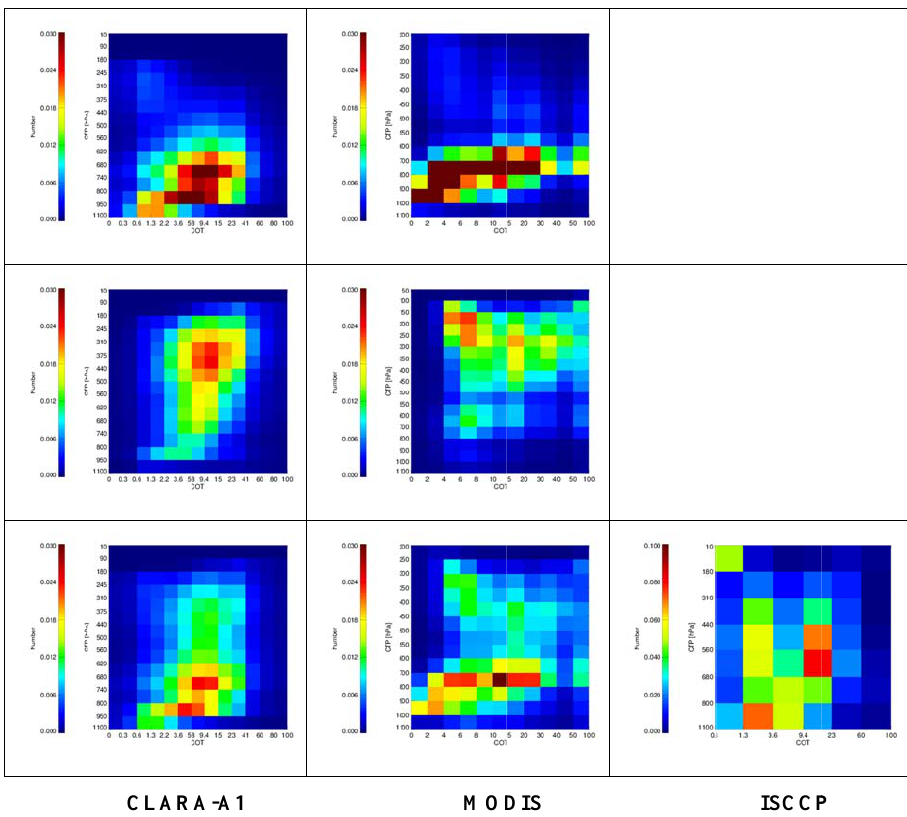
Fig. 6. Cloud-top pressure–cloud optical thickness (CTP–COT) histograms of CLARA-A1 (left column), MODIS-AQUA (middle column), and ISCCP (right column) for liquid clouds (upper row), ice clouds (middle row) and all clouds (bottom row), all for March 2007. The histograms are presented in absolute number occurrence. The range of CTP values is 10–1100hPa (MODIS CTP range is 50/200 to 1100hPa) from top to bottom and for COT 0–100 from left to